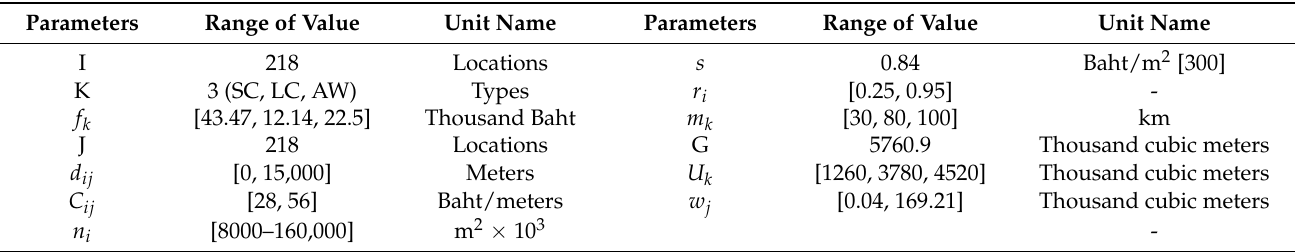
Table 1. Ranges of the parameters used in the case